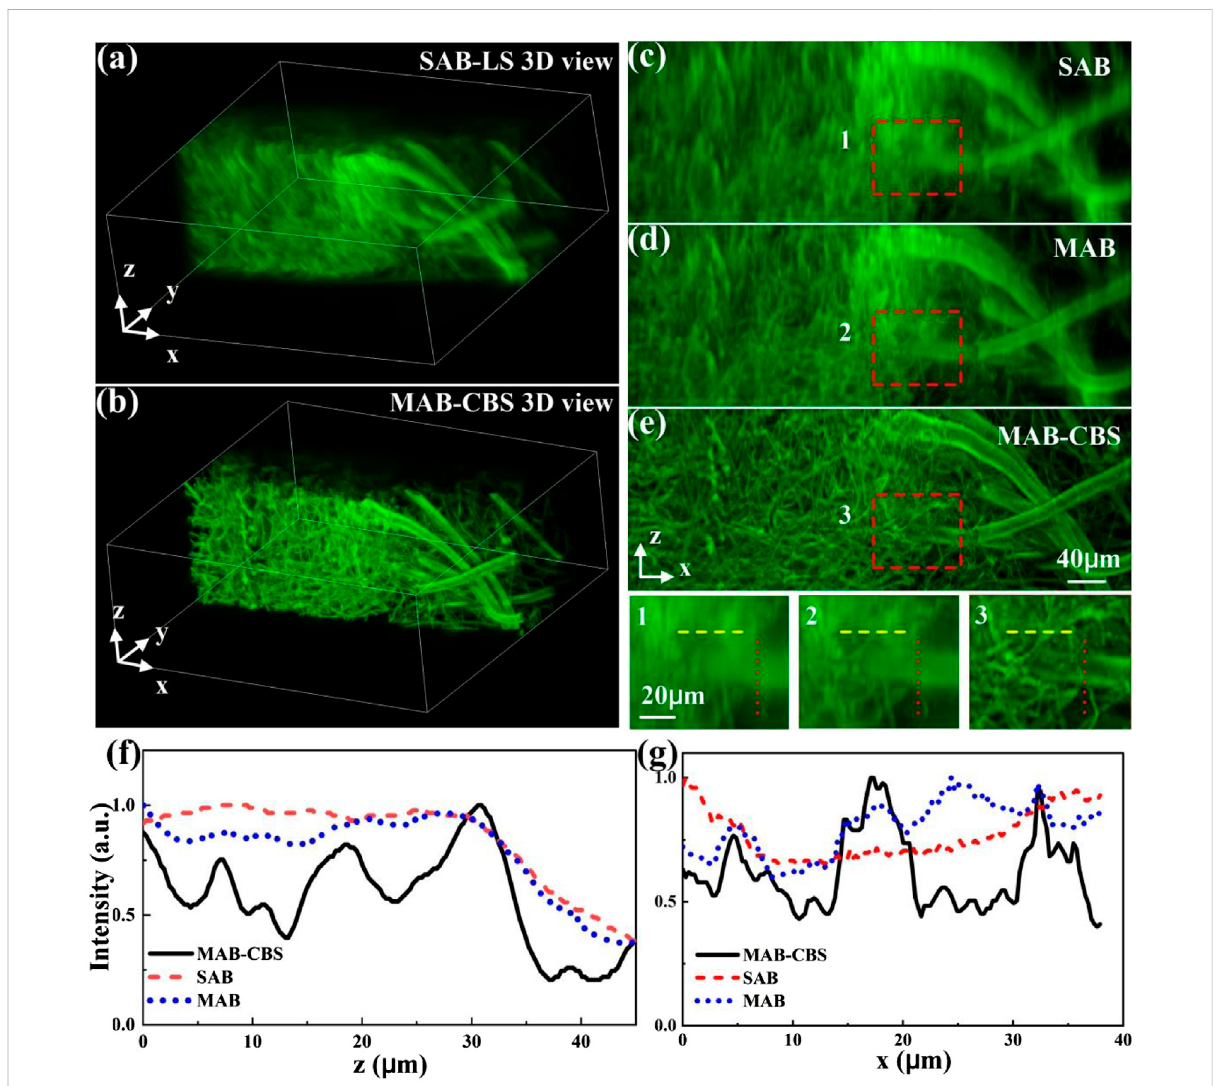
FIGURE 4 Imaging results of aspergillus conidiophores excited by 488 nm laser. (A) and (B) The 3D views of the sample imaged by using the SAB light- sheet and the MAB-CBS method, respectively. (C – E) The xz -plane MIP images of the sample by using the SAB light-sheet, the MAB light-sheet and theMAB-CBSmethod.1,2,3,arethezoom-inpartsofthemarkedareasindicatedin (C – E) . (F) and (G) Thenormalizedintensitypro fi lesalongthered dotted lines and along the yellow dashed lines in 1, 2, 3,